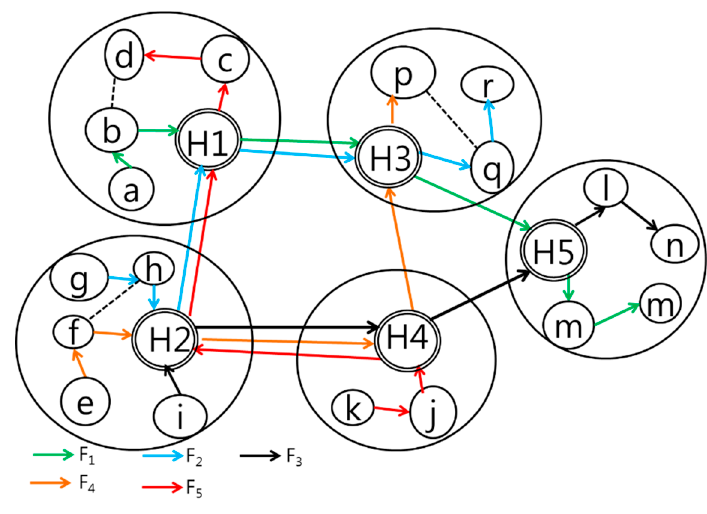
Figure 2. Cluster-based real-time flows.